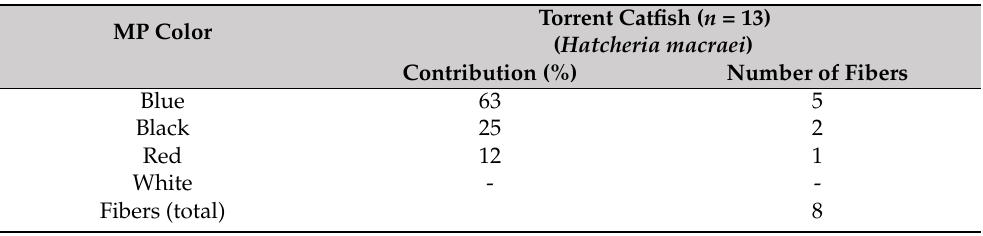
Table 2. Percentage contribution and total number of MP fibers in the GITs of the native torrent catfish collected from the Mendoza